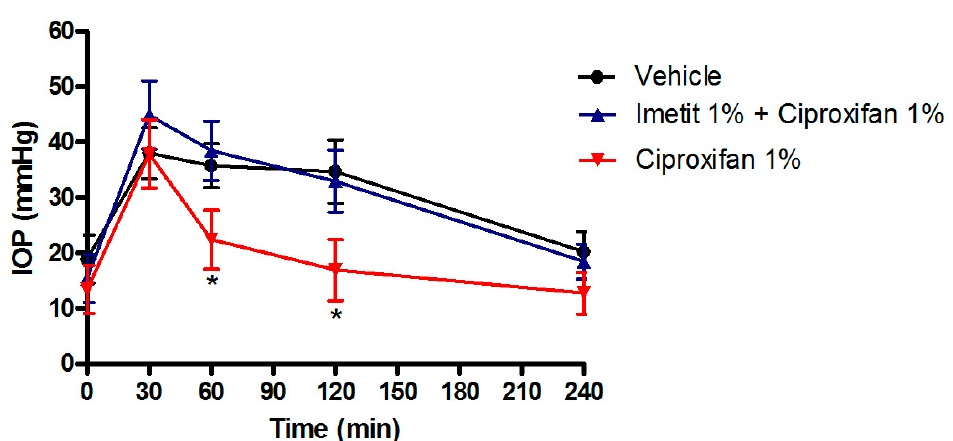
Figure 2. IOP lowering effect of ciproxifan in the transient ocular hypertensive model in NZW rabbits. The effect of ciproxifan is suppressed by pre-treatment with 1% imetit. * p < 0.05 ciproxifan 1% at 60 ′ and 120 ′ vs. vehicle and imetit 1% + ciproxifan 1%. All the results are expressed as mean ± SEM ( n = 6). Two-way ANOVA followed by Bonferroni post hoc test.